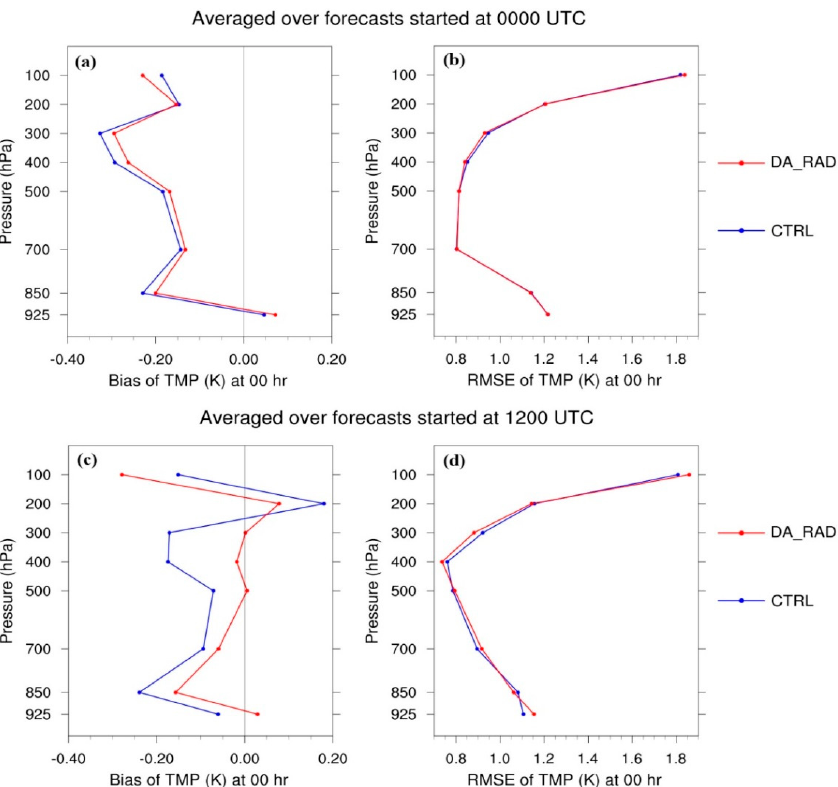
13 of 19 Figure 10. Time series of the 3-h average bias and RMSE for ( a , d ) wind at 10 m and ( b , e ) temperature (TMP) and ( c , f ) humidity (Qv: water vapor mixing ratio) at 2 m for retrospective run forecasts over the period of 1–12 August 2017. To further explore the impact of the satellite radiance observations in RMAPS, we investigated forecasts at different starting times. Because radiosonde observations were available every 12 h, we selected two groups of forecasts that started at 0000 UTC (2017080100–2017081200) and 1200 UTC (2017080112–2017081212) for further investigation. There are twelve 24-h forecasts included in CTRL and DA_RAD for each group. Figure 11 shows the average bias and RMSE of the vertical temperature profiles at the analysis time of 00 h for the forecasts in the two groups. Compared to CTRL, the average bias of the temperature between 300 hPa and 850 hPa in DA_RAD was improved in both groups; however, the improvement in the RMSE was tiny. For the forecasts started at 0000 UTC, the value in DA_RAD is reduced from 0.24 to 0.21 K (approximately 12.5%) for the bias and from 0.910 to 0.905 K (approximately 0.55%) for the RMSE compared to that of CTRL. For the forecasts started at 1200 UTC, an improvement in DA_RAD can be found below 200 hPa for the average bias of the temperature with the value reduced from 0.09 to 0.02 K (approximately 77.8%), and from 0.88 to 0.87 K (approximately 1.14%) for the average RMSE between 300 hPa and